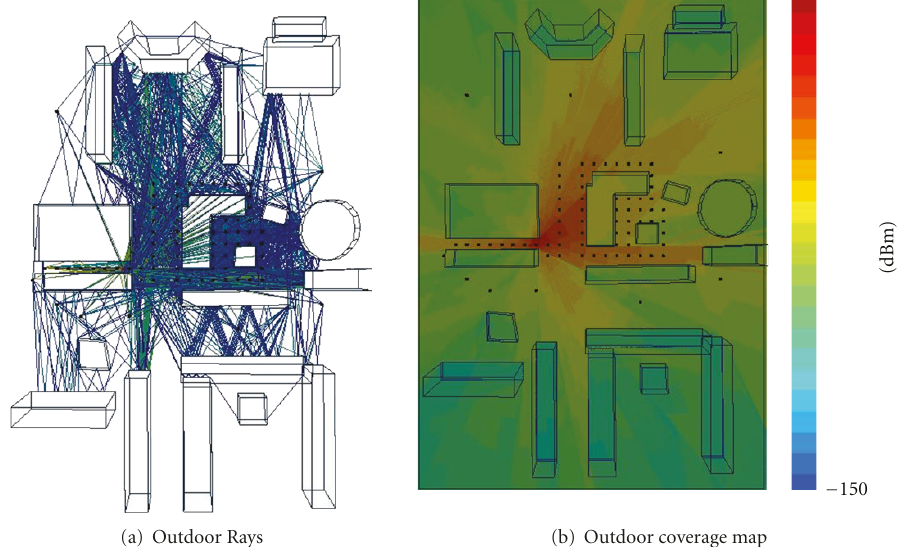
Figure 4: IRLA simulation (Experiment 1).